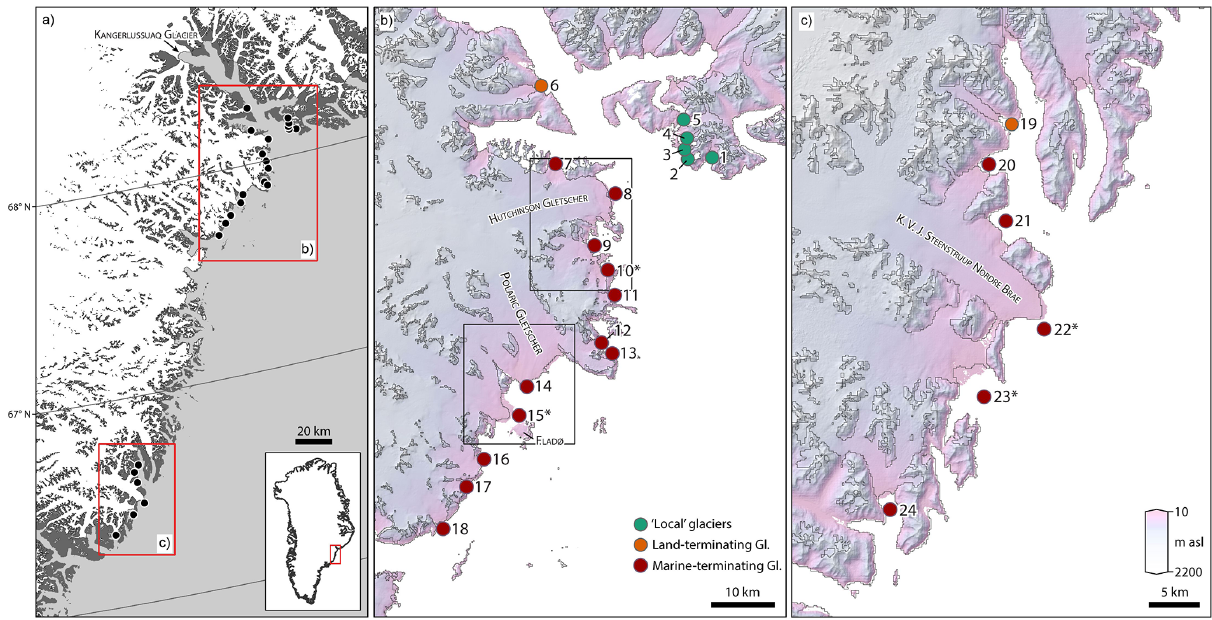
Figure 1. (a) Study location in East Greenland. Inset shows that the area of interest is in the central-eastern coastal region. Red boxes (labelled b and c) identify the northern and southern regions. The black dots within these boxes each represent the studied glaciers. (b) Northern study region incorporating 18 separate glaciers. Coloured circles indicate studied outlets, where the colour is indicative of the glacier type (see key). The largest outlets in this region are the Hutchinson Glacier (Glacier 8) and the Polaric Glacier (Glacier 14). Black boxes indicate further subdivisions of this area, discussed in the text. (c) Southern study region, incorporating six outlets, the largest of which is the KVJ Steenstruup Nordre Glacier (Glacier 22). Again, coloured dots represent glacier type, whilst the background in both (b) and (c) is shaded according to elevation (data provided by Bedmachine v3; Morlighem et al.,